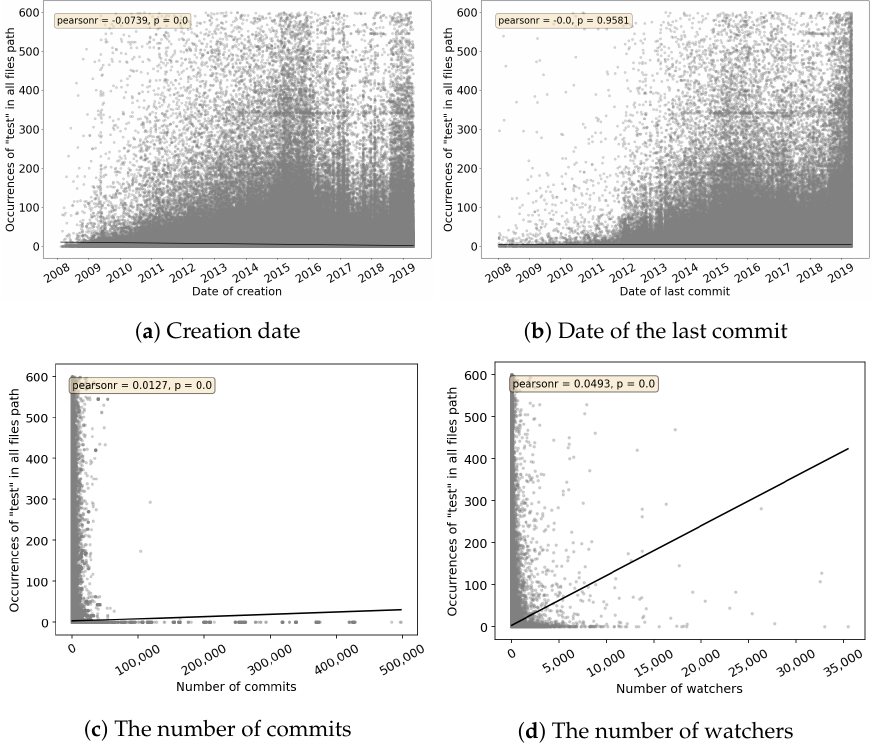
Figure A2. Correlation between the number of occurrences of the word “test” in all files path and project’s life cycle parameters.